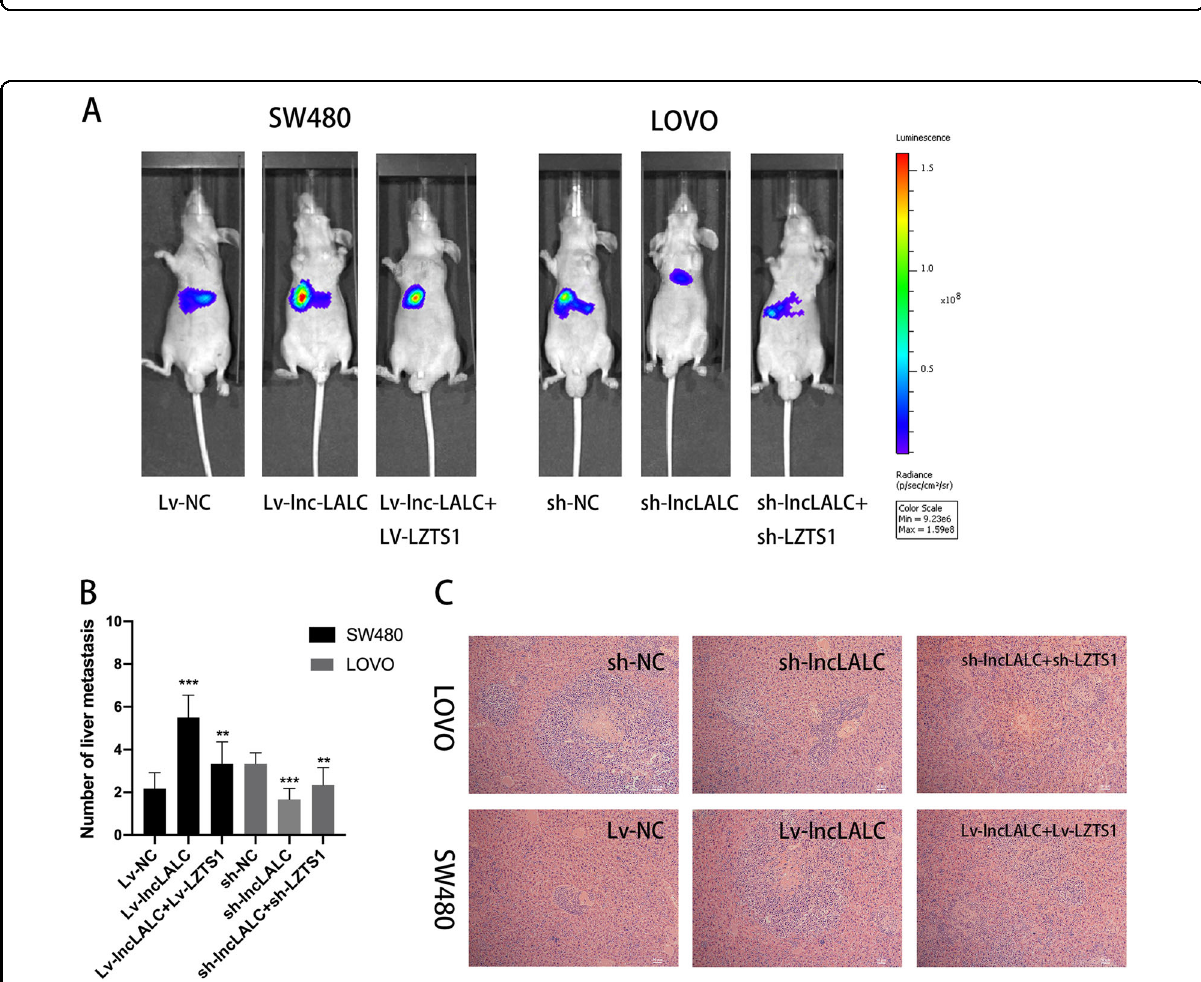
Fig. 4 Lnc-LALC enhanced CRC cells metastasis ability in vivo. A Hepatic metastasis models were conducted by injecting CRC cells (2 × 10 7 cells suspended in 200 μ L PBS) into the spleen of 48 BALB/c nude mice in 6 groups (8 in each group) and liver metastasis was investigated respectively using the IVIS Lumina II system. Representative images in each group were presented. The fl uorescence intensity was highest in Lv-lnc-LALC-SW480 group and lowest in sh-lncLALC-LoVo group. B Hepatic metastatic tumors in different groups with volumes >2 mm 3 were identi fi ed and compared. Lv-NC-SW480 group and sh-NC-LoVo group were used as a control in two cell lines respectively. * P < 0.05; ** P < 0.01; *** P < 0.001. C H&E staining con fi rmed the pathological pattern of the hepatic metastatic nodules in these six groups was metastatic adenocarcinoma(original magni fi cation ×